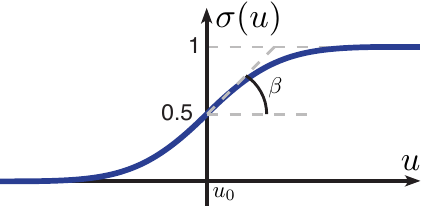
Figure 1: Sigmoid function from Equation 2 rising smoothly from 0 to 1 as a given threshold u 0 is approached. The slope at the thresh- old is defined by the parameter β , larger β -values correspond to steeper growth.